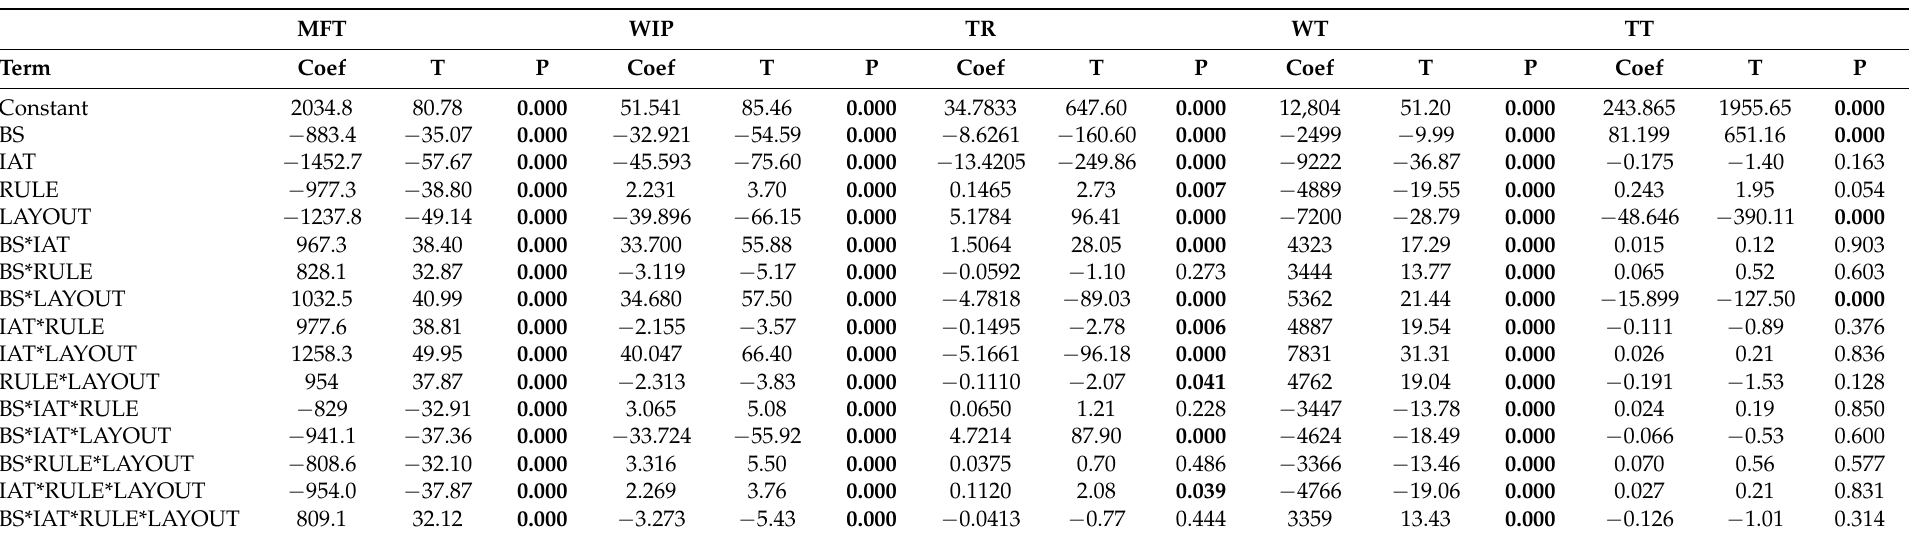
Table 6. Estimated coefficients of the simulation